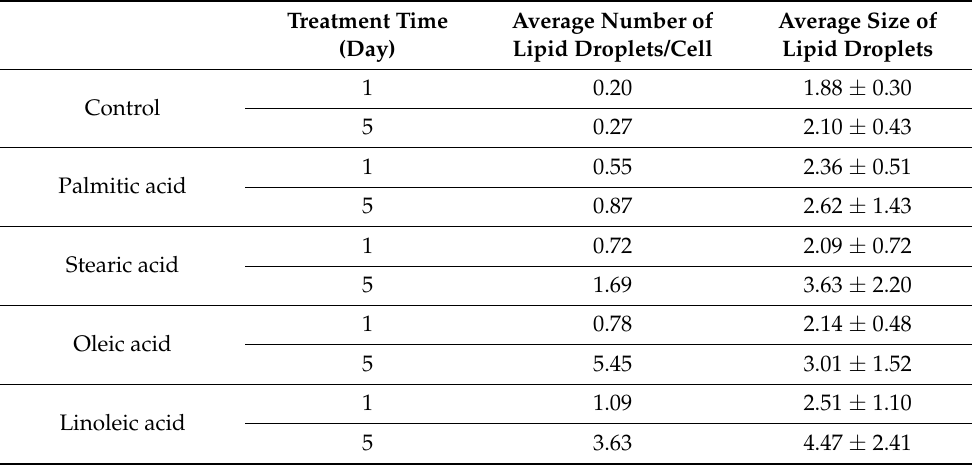
Table 1. Average diameter and number of lipid droplets found in the cells co-cultured with fatty